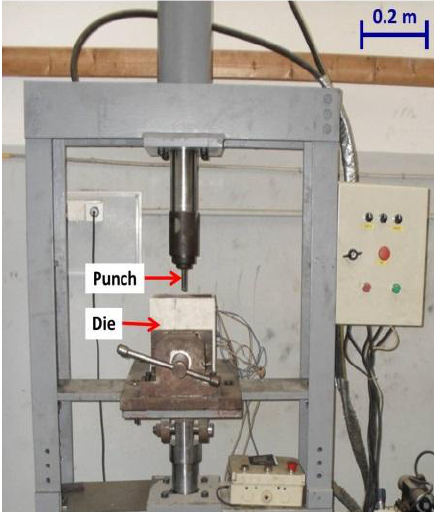
Figure 6. Experimental setup of squeeze casting process.